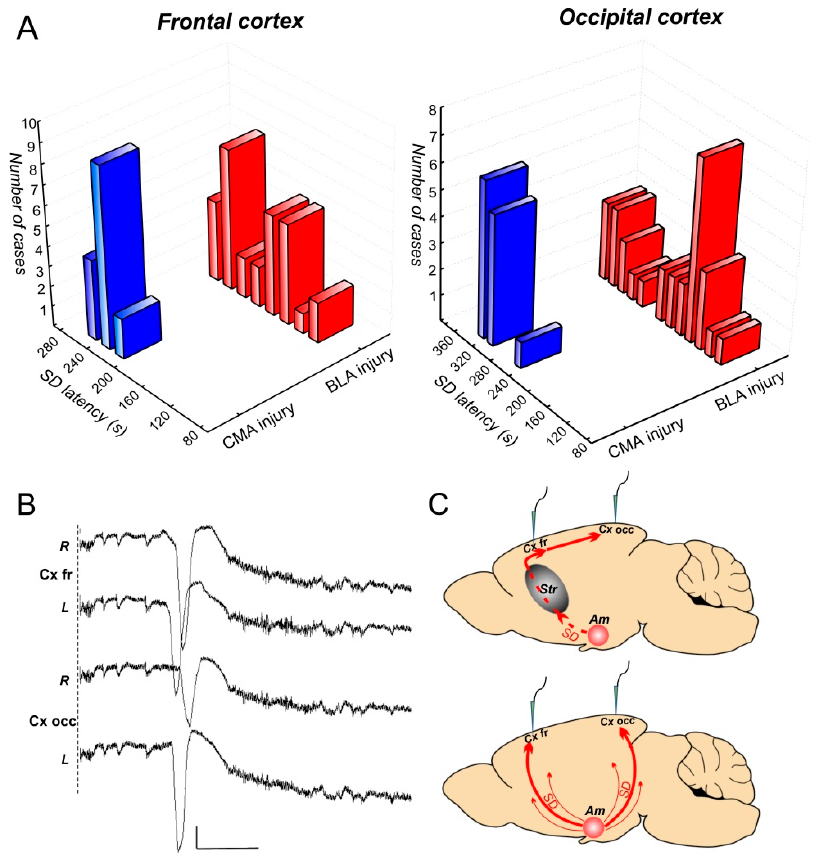
Figure 3. ( A ) Latencies of SD appearance in the frontal (Cx fr) and occipital (Cx occ) cortices after CMA and BLA injury; ( B ) DC recording of SDs induced by the bilateral injury of the BLA in the frontal and occipital cortical areas of the two hemispheres; scale bars—100 s and 2 mV; negativity is directed downward; ( C ) schemes of the two pathways of SD propagation from the amygdala to the cortex via the striatum and frontal pole (above) or via the temporal cortex (bottom). Str—the striatum, Am—the amygdala.